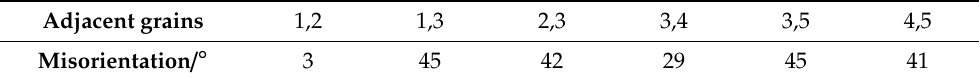
Figure 12. Stress concentration at the grain boundary marked as letter a, MPa.